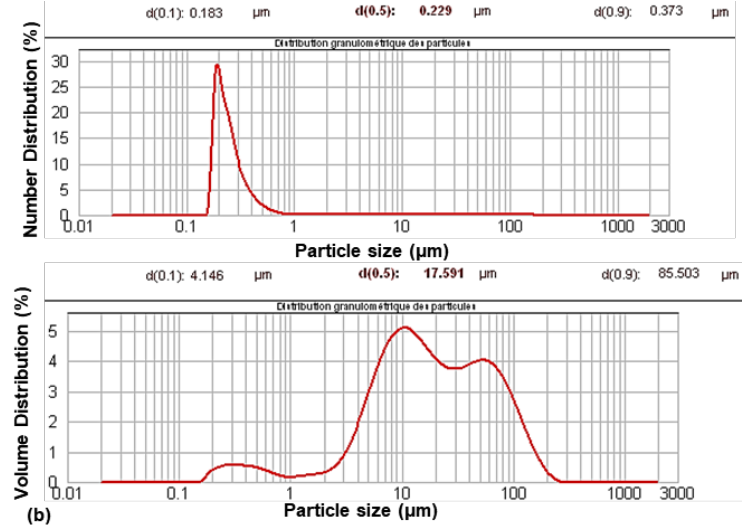
Figure 1. Granulometric curves of PCC before ( a ) and after modification ( b ).